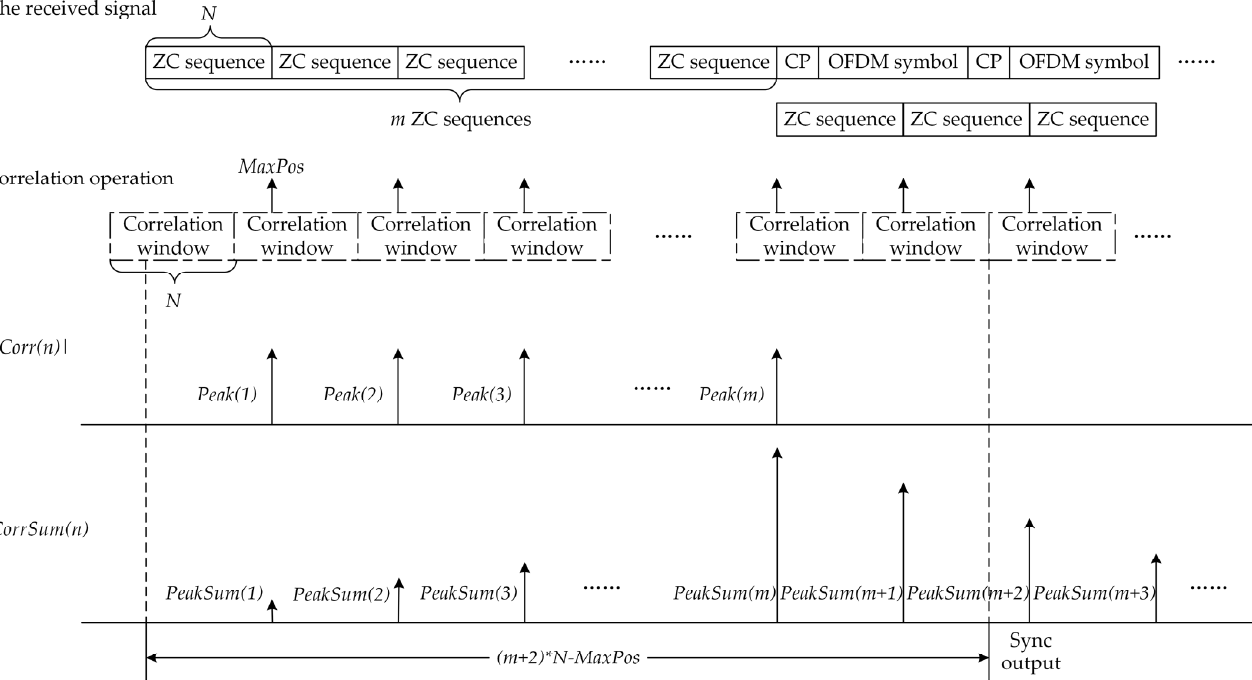
Figure 6. The amplitude variation of